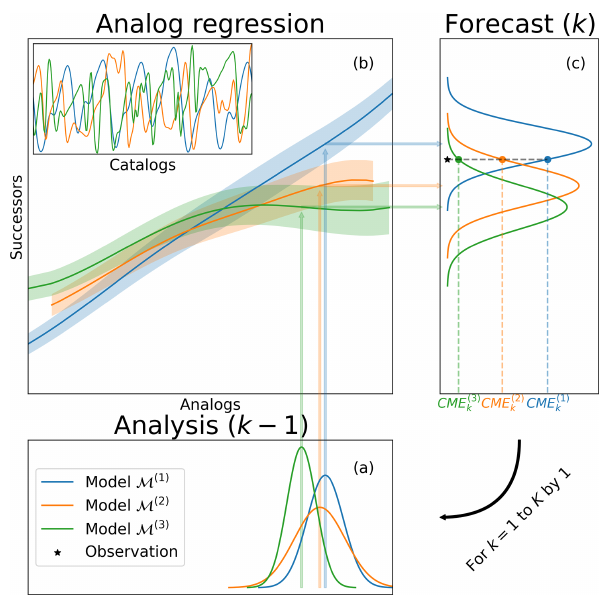
Figure 1. Schematic representation of the proposed methodology. The procedure is iterative, from an initial to a final time index. At time index k − 1, the procedure starts with the results of different DA systems in (a) , corresponding to different dynamical models. In (b) , each analysis state is used to find the nearest analogs. Those analogs and corresponding successors, coming from catalogs of nu- merical simulations, are used to build analog regressions. The re- sulting probabilistic forecasts given in (c) are compared to the avail- able observations at time index k . Then, the likelihoods (CMEs) are used to compute a weight for each dynamical model.